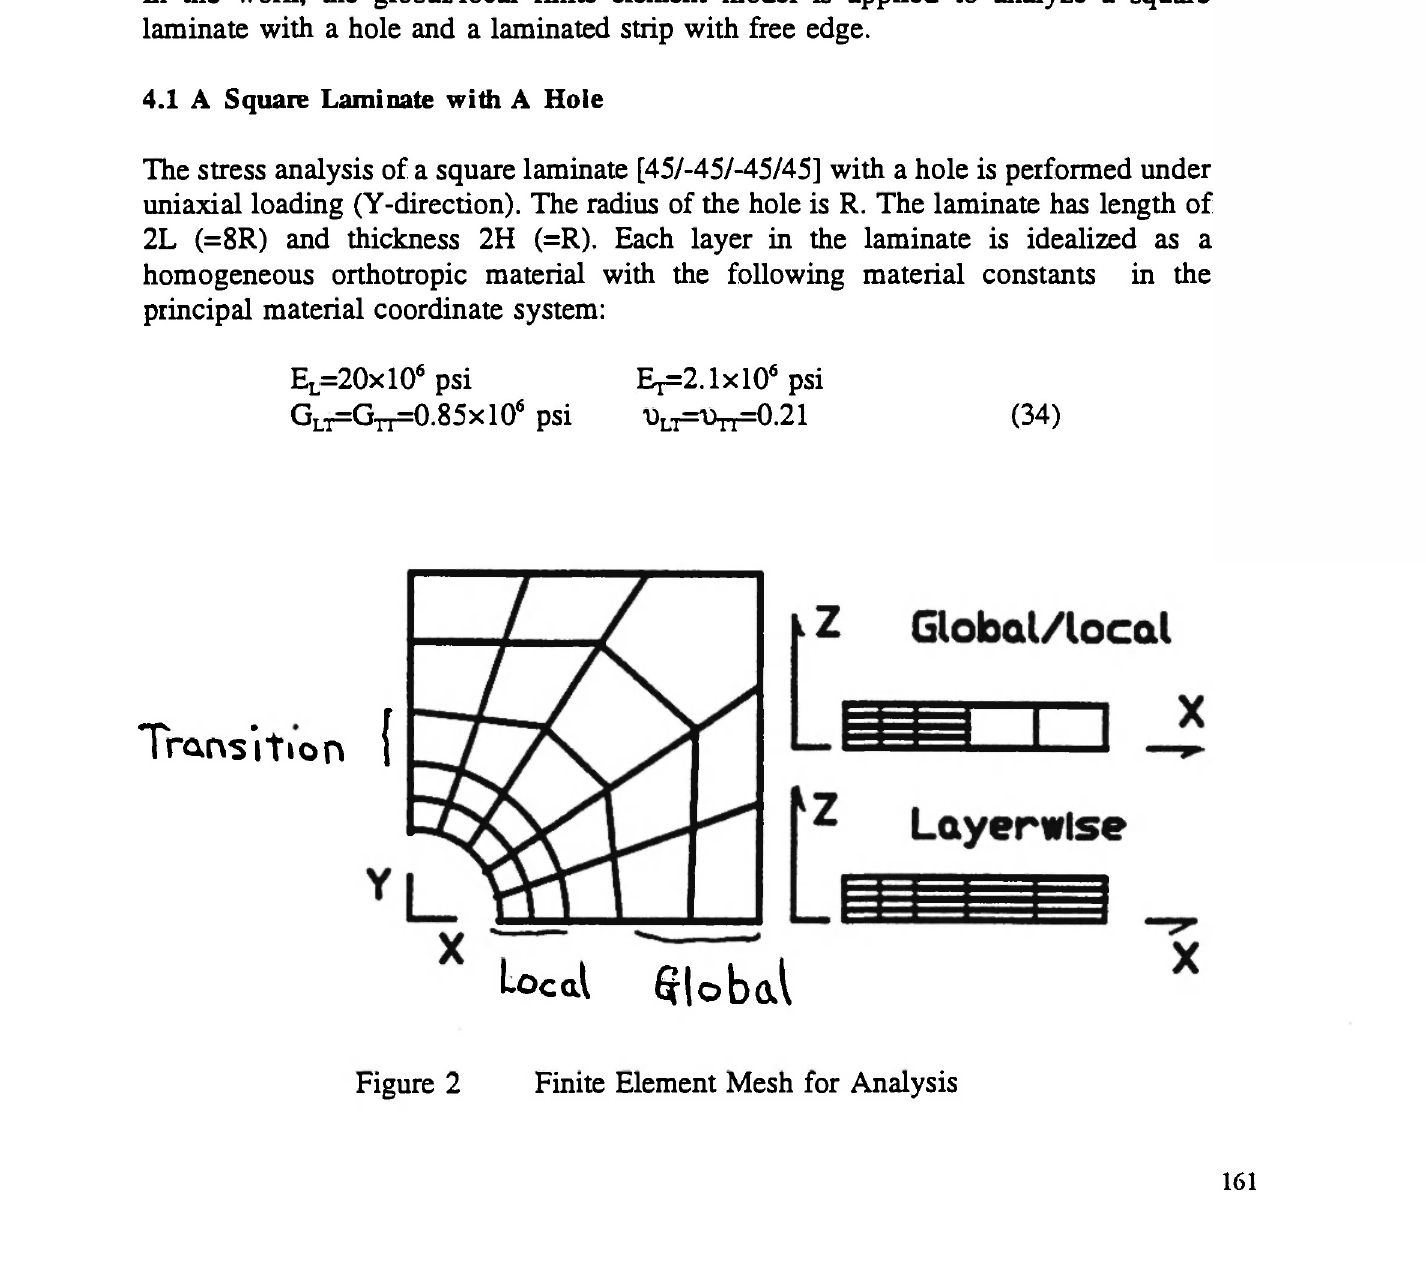
Figure 2 Finite Element Mesh for